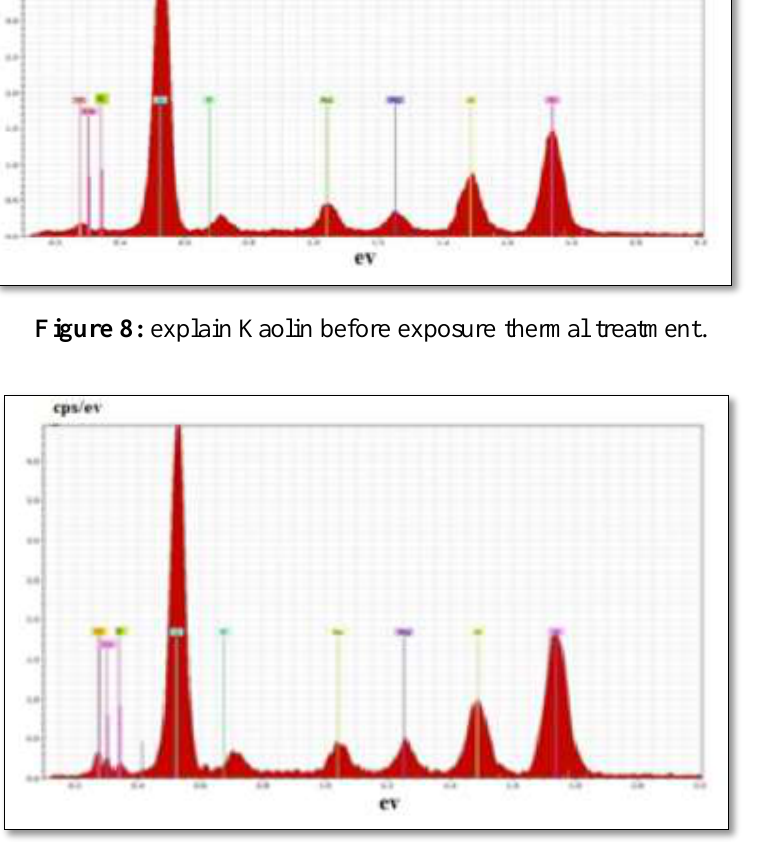
Figure 9: explain Bentonite before exposure thermal treatment .